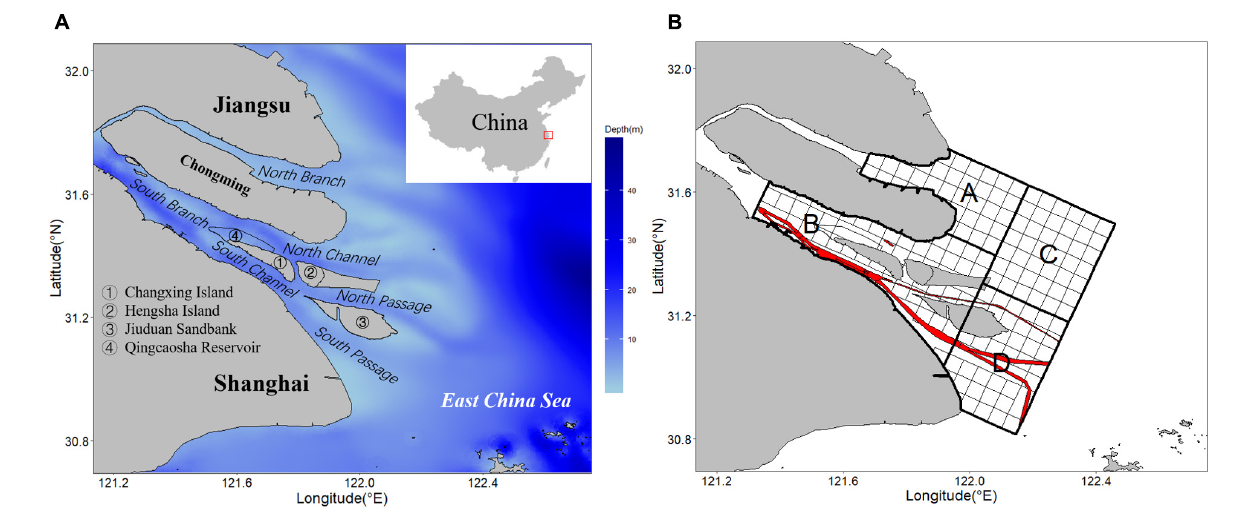
FIGURE 1 | (A) Study area with depth of water in the Yangtze Estuary. The red rectangle on the China map is the location of the Yangtze Estuary. (B) Subareas A, B, C, and D. Red line is the Deepwater Navigation Channel (DNC).